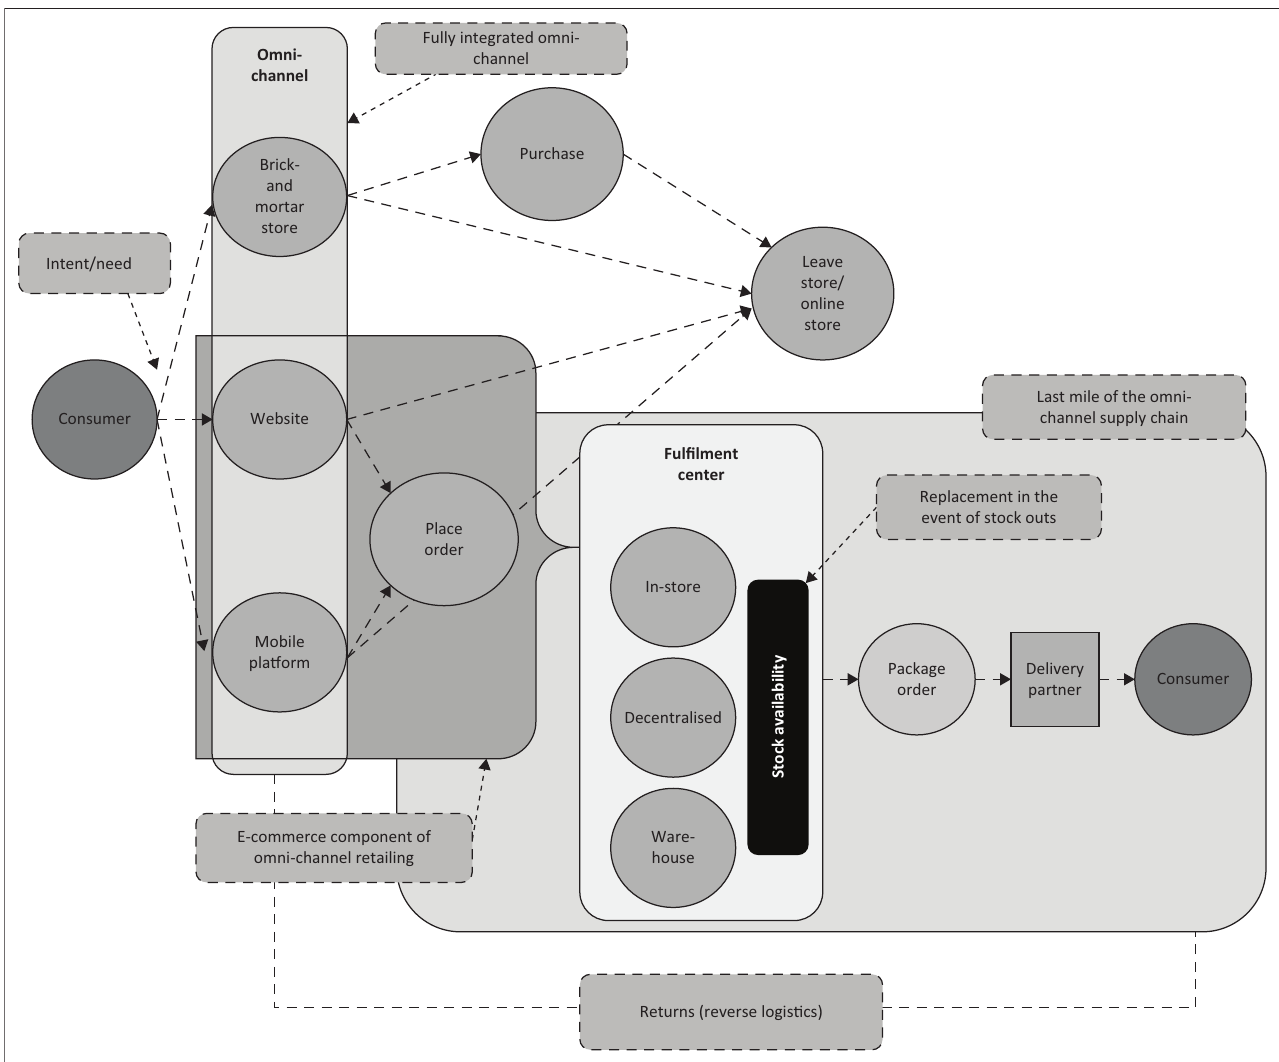
FIGURE 1: Generic process of omnichannel